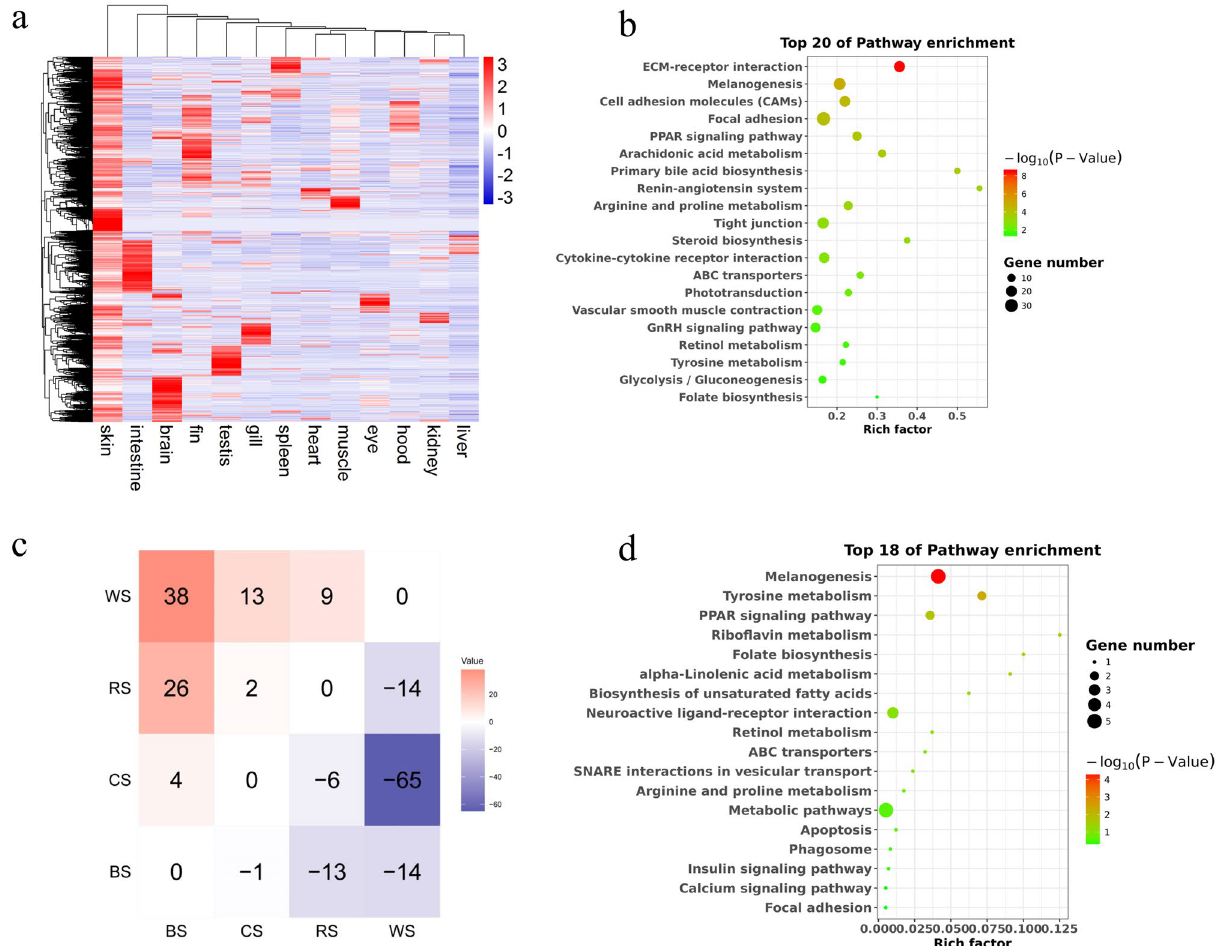
Figure 6. Analyses of skin- and color-specific gene expressions. ( a ) Heatmaps of skin-specific gene expression. ( b ) Top 20 pathways enriched with skin-specific genes. ( c ) Comparisons of differentially expressed genes between four different color skins. ( d ) Top 18 pathways enriched with differentially expressed genes in different color skins. BS: black skin; CS: cyan skin; RS: red skin; WS: white skin. The figures were constructed in pheatmap R package 1.0.12 (https ://CRAN.R-proje ct.org/packa ge=pheat map) and ggplot2 (https ://ggplo t2.tidyv